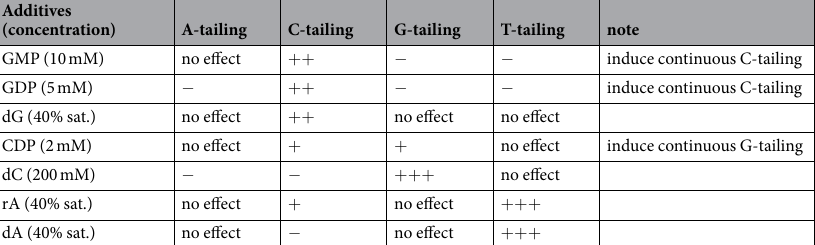
Table 1. Effects of additives on A, C, G, and T-tailing a . a ‘ + ’, positive effect increasing the tailing index by